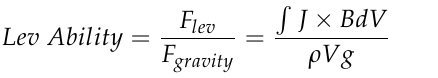
for different ρ